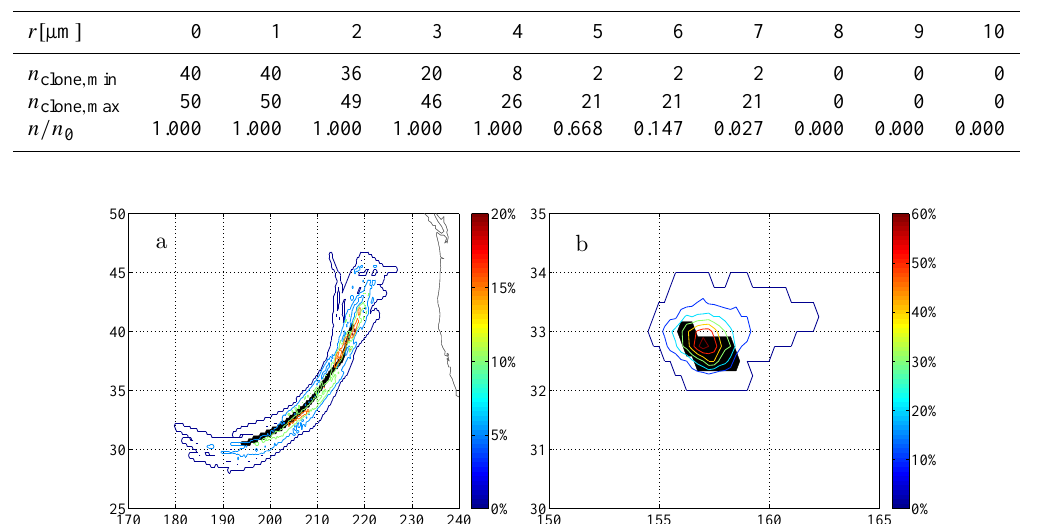
Fig. 6. Colored contours and gray contours indicate the ensemble mean and deterministic “concentration”, respectively, in a 0 . 25 ◦ × 0 . 25 ◦ (a) air column for r = 1 µ m , and (b) cell for r = 10 µ m “deposited” particles after 2.5 days. Axis labeling corresponds to geographical coordinates in degree.